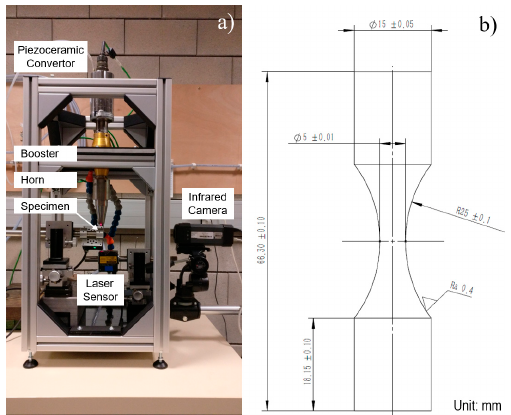
Figure 1. Ultrasonic fatigue test device and geometry of the Inconel 718 specimen: ( a ) schematic of device, ( b ) geometry of specimen.